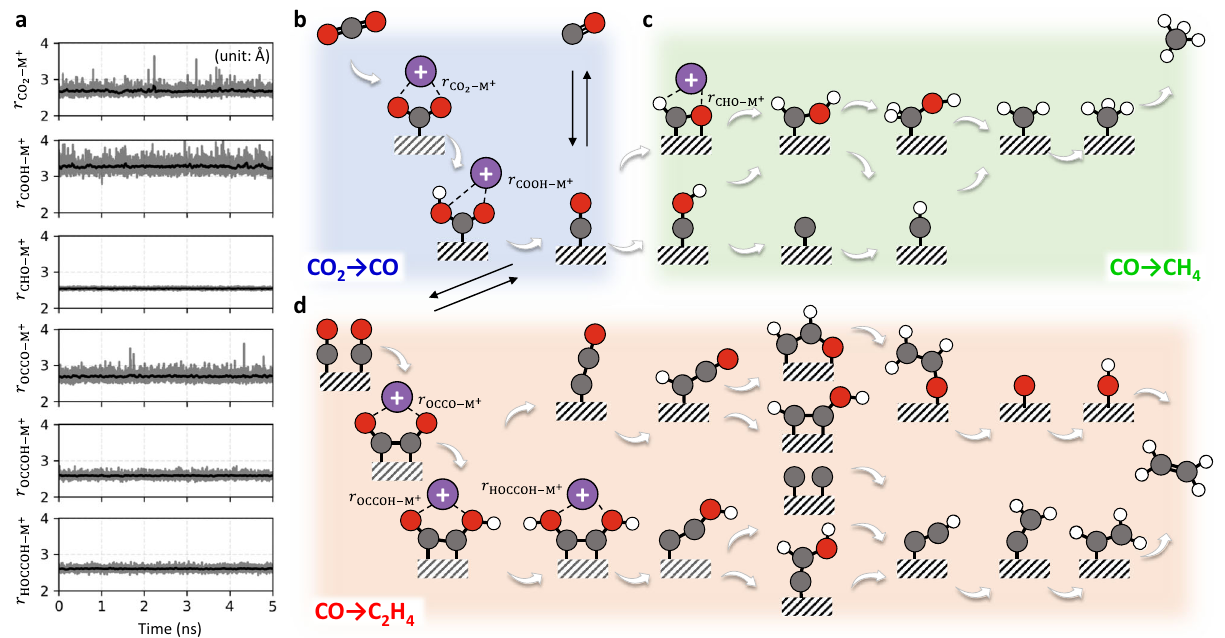
Fig.1|Mapofcation-(un)coordinatedintermediatesduringCO 2 RR.a Temporal changeofdistance( r )betweenintermediateandK + during5-nsDFT-CEStrajectory (grey line). Applied potential is − 1.0 V SHE . The black solid line denotes a moving average of the grey line using a 0.05-ns time window. b – d Possible intermediates forCO 2 RR,wherecation-coordinatedspeciesareidenti fi edwithomittingthewater moleculesforvisualclarity.Reactionpathsaredenotedusingdifferentbackground